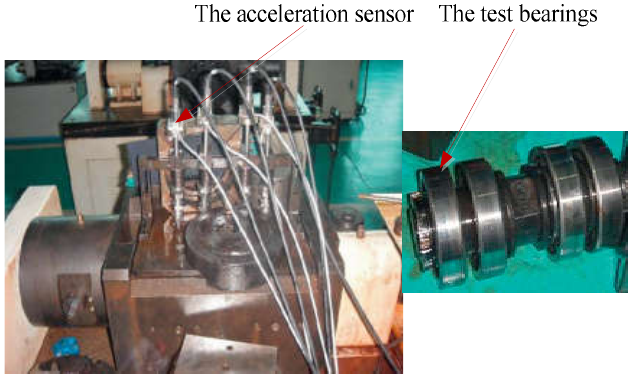
Figure 10. ABLT-1A test rig.